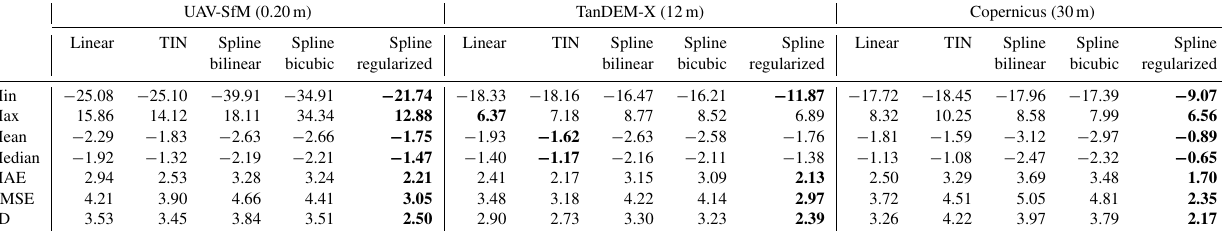
Table 1. Interpolation error metrics. Minimum (min), maximum (max), mean, median, mean absolute error (MAE), root-mean-square error (RMSE), and standard deviation (SD) of the elevation differences between the interpolated and DEM surface for the 50 fictive lavaka polygons considering all pixels. The interpolation method yielding the lowest error is indicated in bold for each DEM and error metric. UAV-SfM